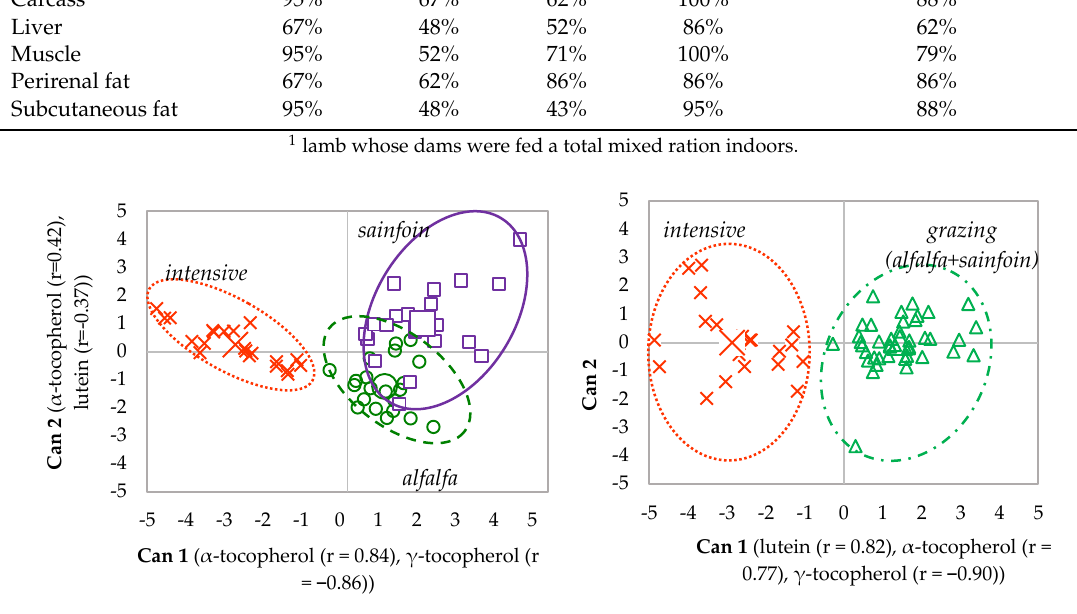
Figure 4. Canonical discriminant plots among maternal feedings in plasma at weaning.